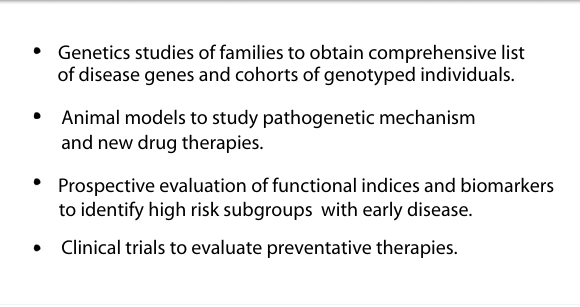
Figure 4. Current research priorities for familial